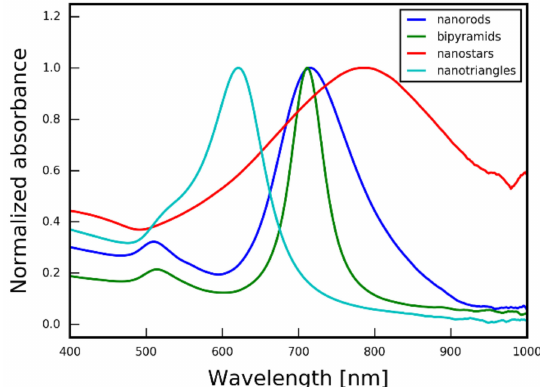
Figure 4. Normalized UV-VIS absorption spectra of gold nanorods, bipyramids, stars, and triangles dispersion. Transmission electron microscope images of these nanoparticles are given in Figure